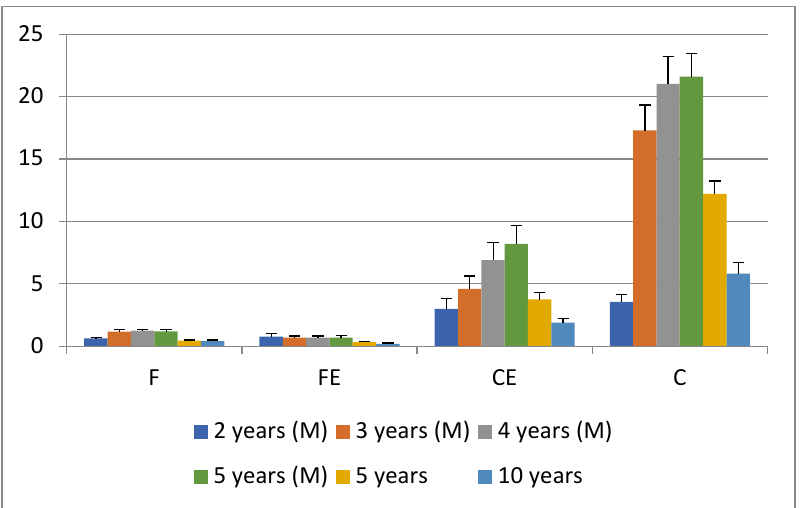
Figure 2. Changes in the average percentage cover of Deschampsia flexuosa in ecotone complex zones (F—forest, FE—forest edge, CE—clear-cut edge, C—clear-cut) during the study period (M—revisited monitoring sites (2nd to 5th post-clear-cutting years)). Mean values and standard errors are shown. Fireweed, Epilobium angustifolium , in the F zone was rather rare, with the percentage cover not exceeding 1%. Its abundance and occurrence in the transitional zone (FE and CE) were also very low (Figure 3).